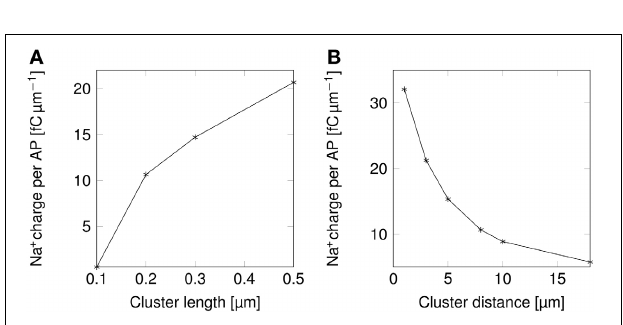
FIGURE 4 | Action potential height and width as functions of channel distributions. When varying the length of lipid rafts, the inter-raft distance was set to 8 µ m. While varying the inter-raft distance, the lipid raft length was set to 0.2 µ m. (A) Action potential width (measured at half-peak value) in a model axon with clustered Na + channels as a function of raft length. (B) Action potential peak in a model axon with clustered Na + channels as a function of raft length. (C) Action potential width (measured at half-peak value) in a model axon with clustered Na + channels as a function of distance between lipid rafts. (D) Action potential peak in a model axon with clustered Na + channels as a function of distance between rafts.